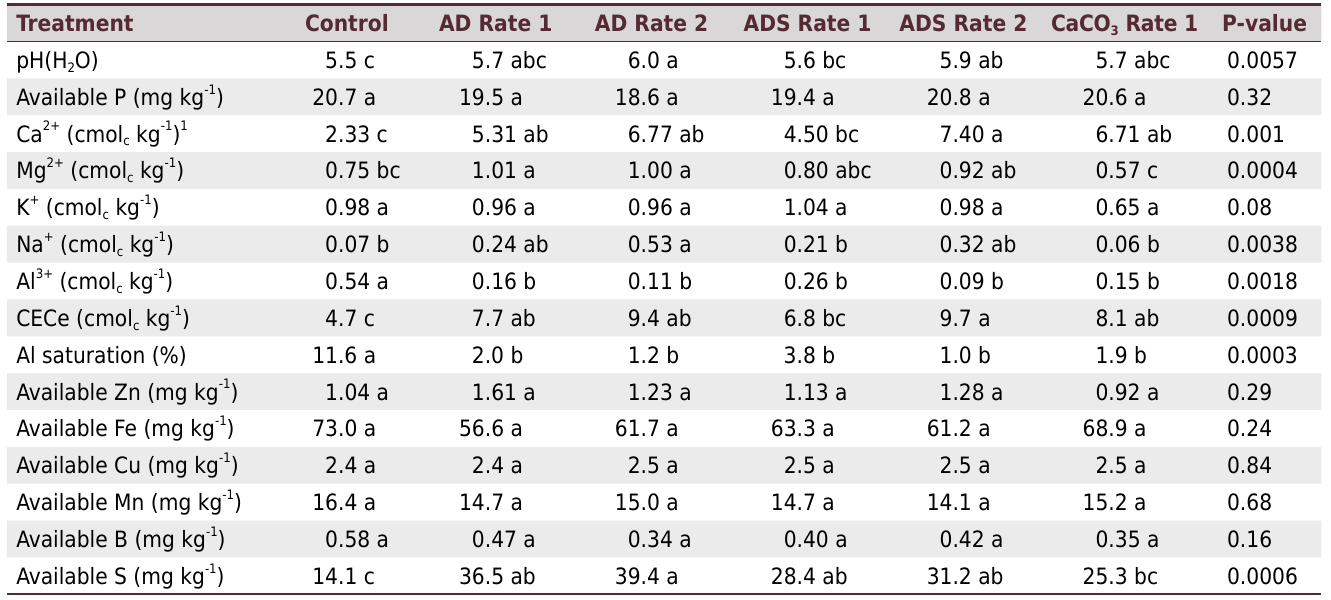
Table 5. Soil chemical properties at the Remehue location 360 days after the application of six soil acidity control treatments